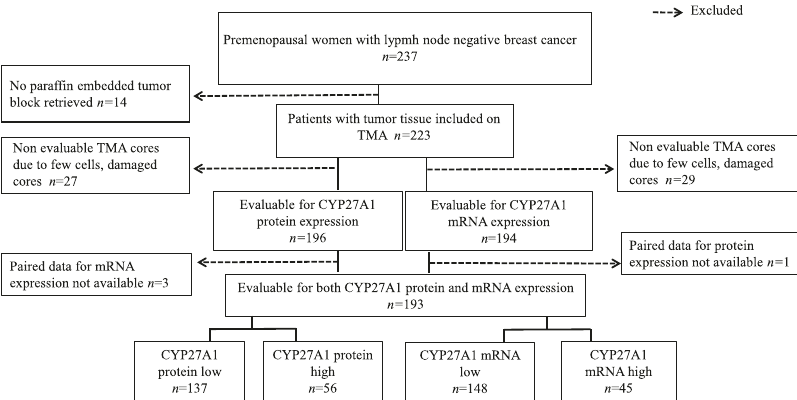
Fig. 5 CONSORT diagram of the study. Flowchart showing numbers of patients included in and excluded from the